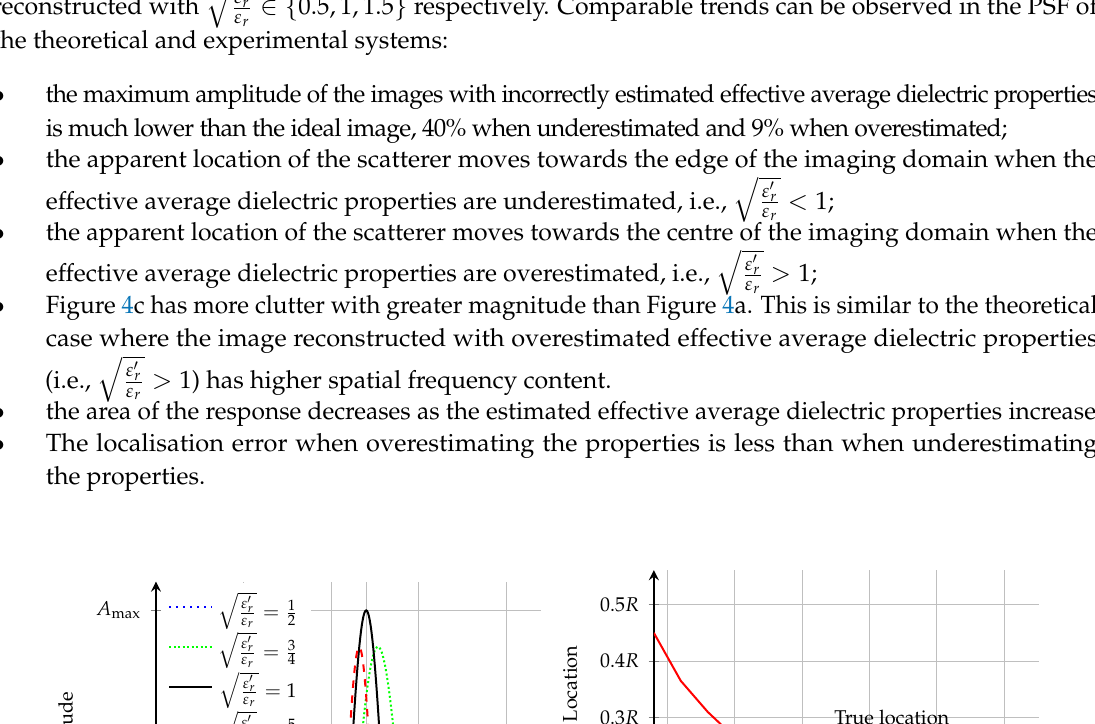
respectively, where fatty breast interior has dielectric properties of ε r = 6. Hence, Figure 4a–c are (cid:113) ε (cid:48) r ∈ { 0.5, 1, 1.5 } respectively. Comparable trends can be observed in the PSF of reconstructed with ε r